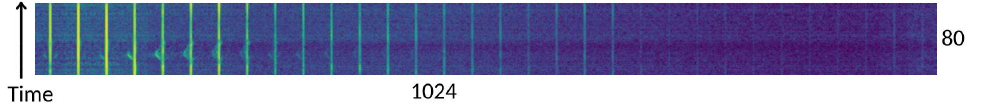
Figure 5. A spectrogram image pre-processed with the dB range [ − 16, 0]. The image is generated by flattening a sequence of 80 range Doppler images. Each row represents one range Doppler image of 32 × 32 =